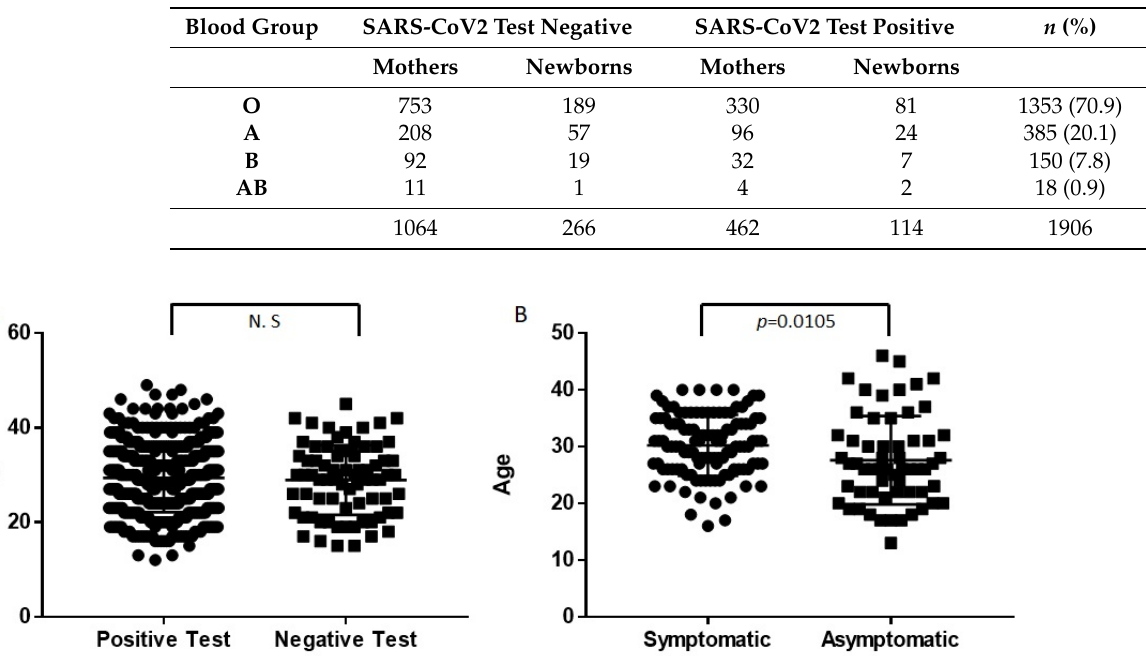
Table 1. Distribution of the study population according to blood groups.